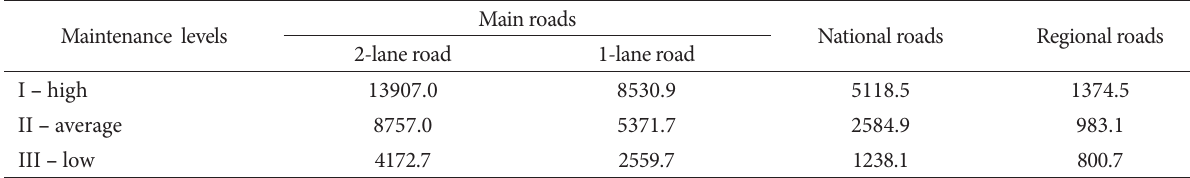
Table 2. The continuous prices (costs) applied in the model for 1 km of winter road maintenance, Eur per year (season) in 2014 (Lithuanian Road Administration under the Ministry of Transport and Communications of the Republic of Lithuania) Maintenance